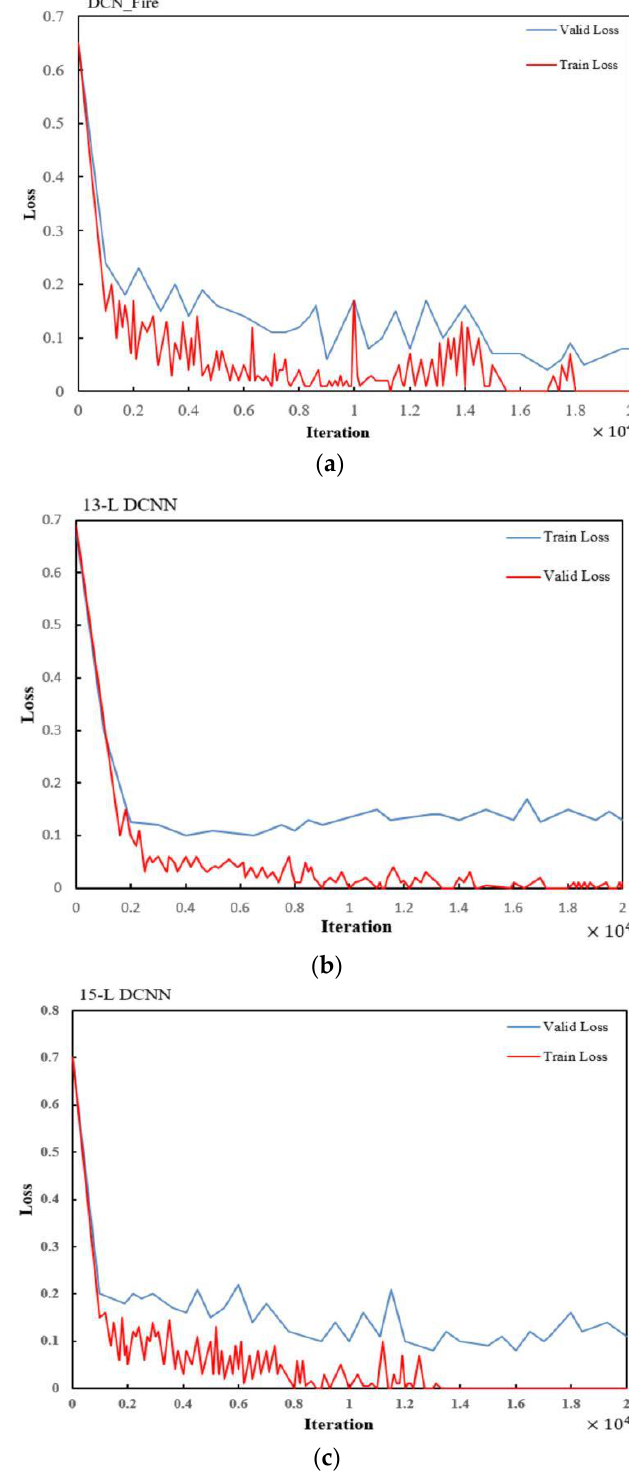
Figure 6. Training and validation loss curve of ( a ) the DCN_Fire model, ( b ) the 13-layer DCNN model, and ( c ) the 13-layer DCNN model.